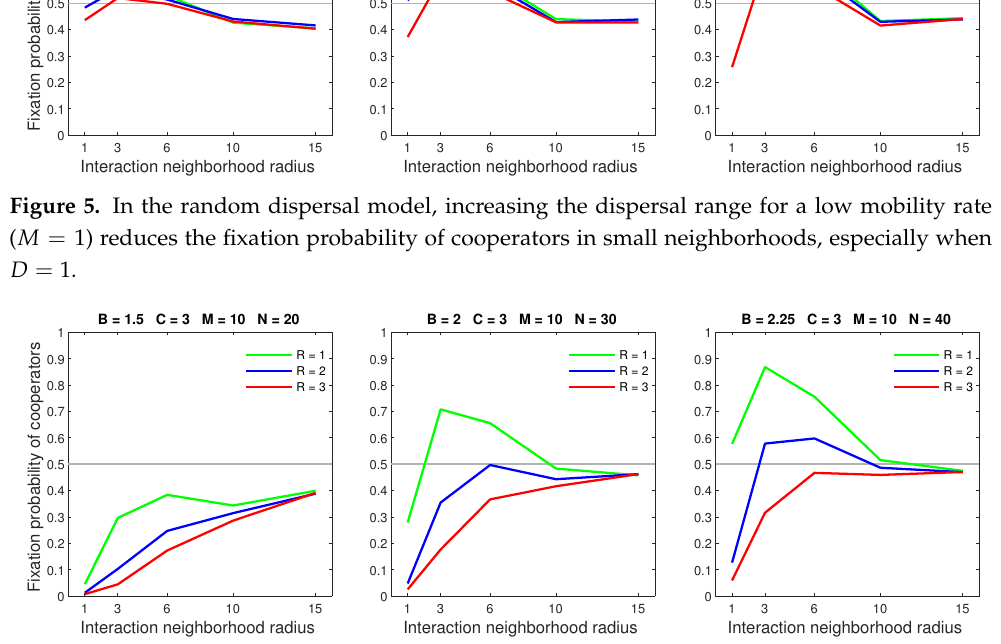
Figure 6. In the random dispersal model, increasing the dispersal range for a high mobility rate ( M = 10) causes a breakdown in cooperation in neighborhoods that are sufficiently